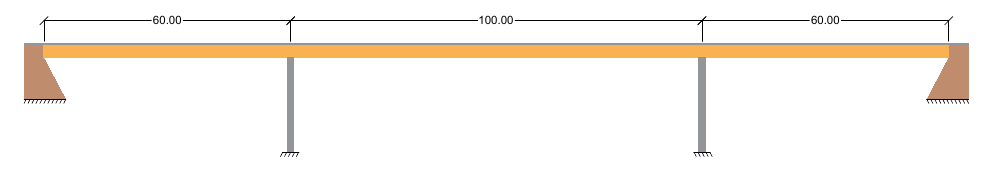
Figure 2. Bridge spans length of the SCC